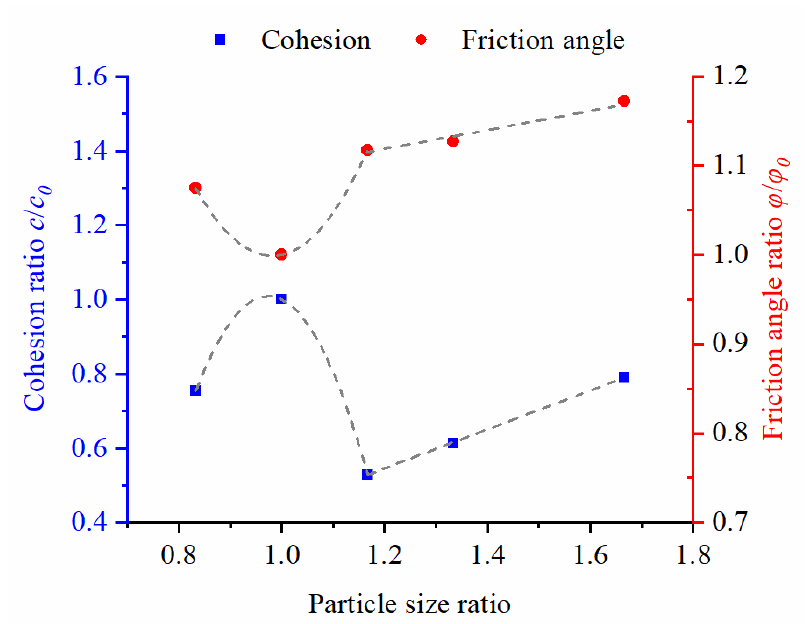
Figure 13. Relationship between strength-parameters ratio and particle-size ratio.